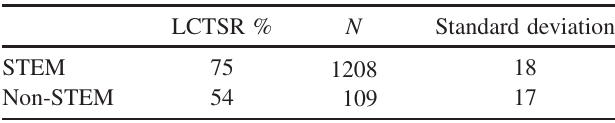
TABLE I. Average LCTSR scores for STEM and non-STEM majors. LCTSR %